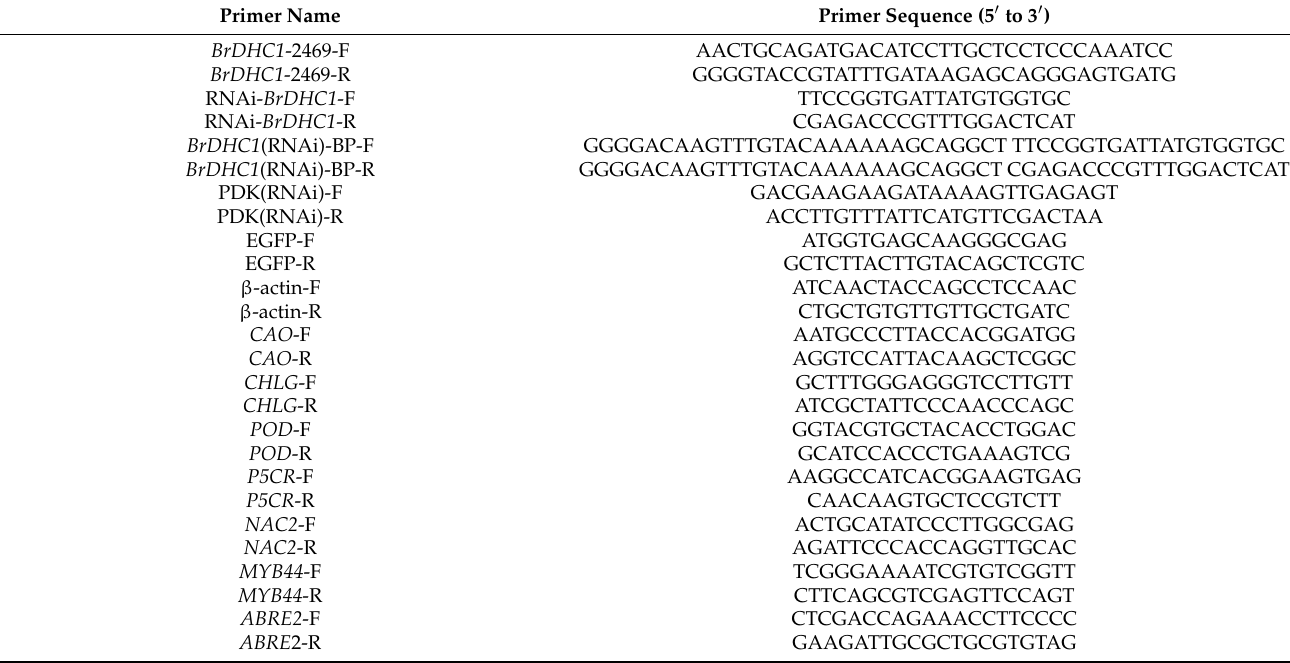
Table A1. Information of Primer